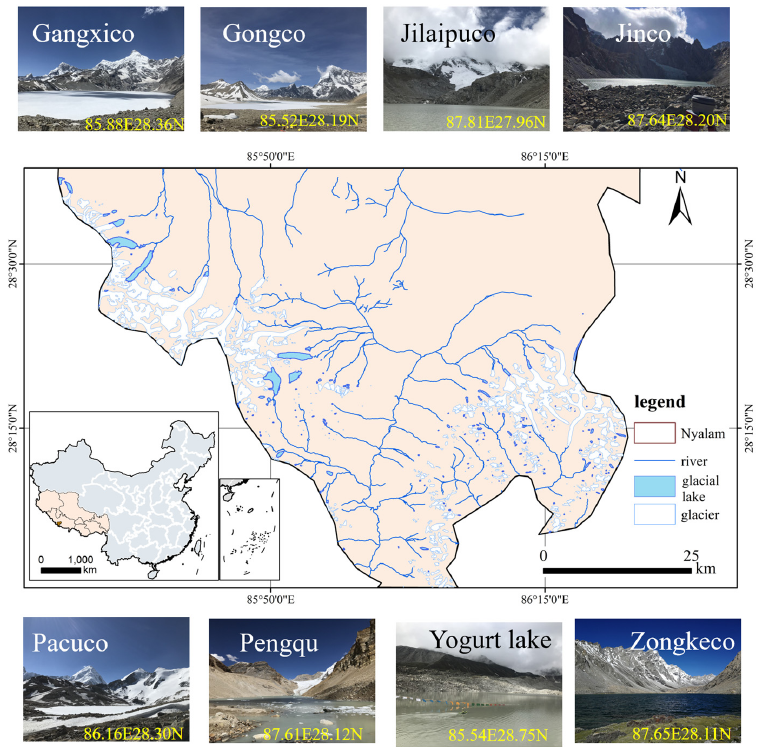
Figure 1. Study area and distribution of glacial lake area change. Table 1. Data of the study